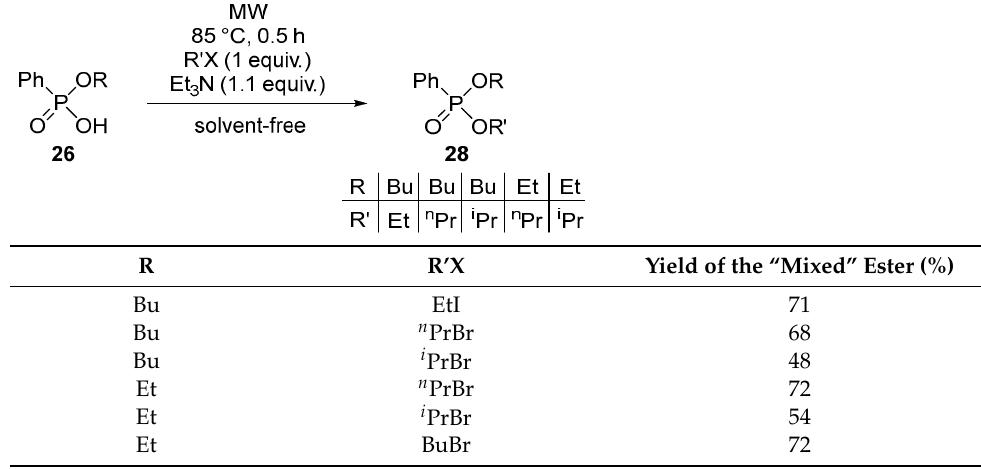
Table 7. The preparation of phenylphosphonates ( 28 ) with different alkyl groups.